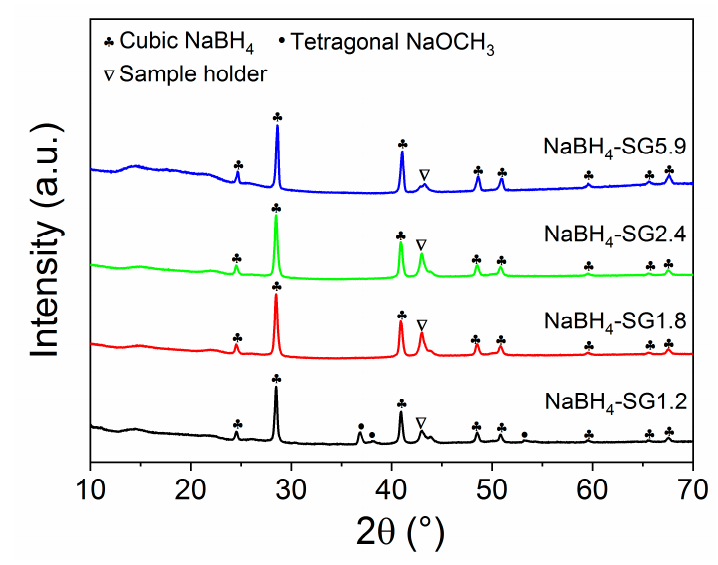
Figure 2. XRD patterns the as-synthesized NaBH 4 via solid-gas interaction.